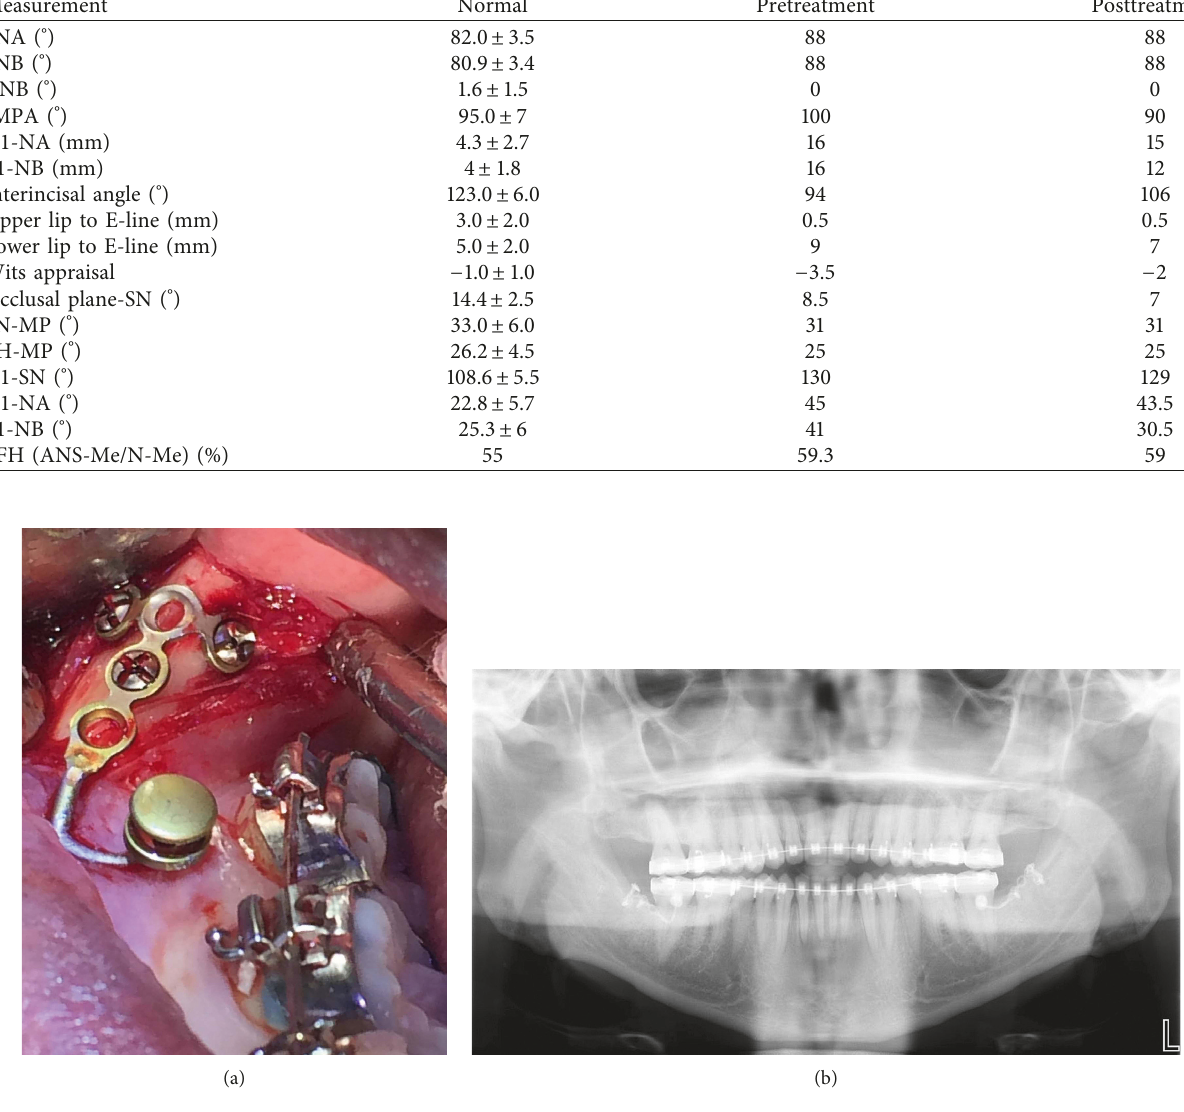
Figure 4: Surgical procedure: (a) intraoral photograph of reflected flap and fixed miniplate; (b) panoramic radiograph after placement of the